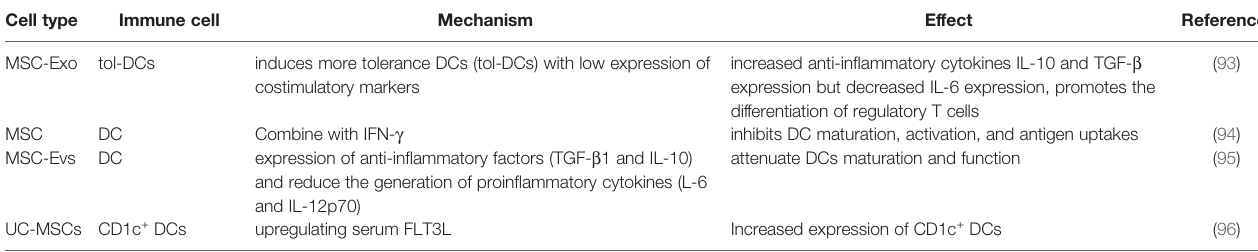
TABLE 3 | Mechanism of action with MSCs and EVs on DC